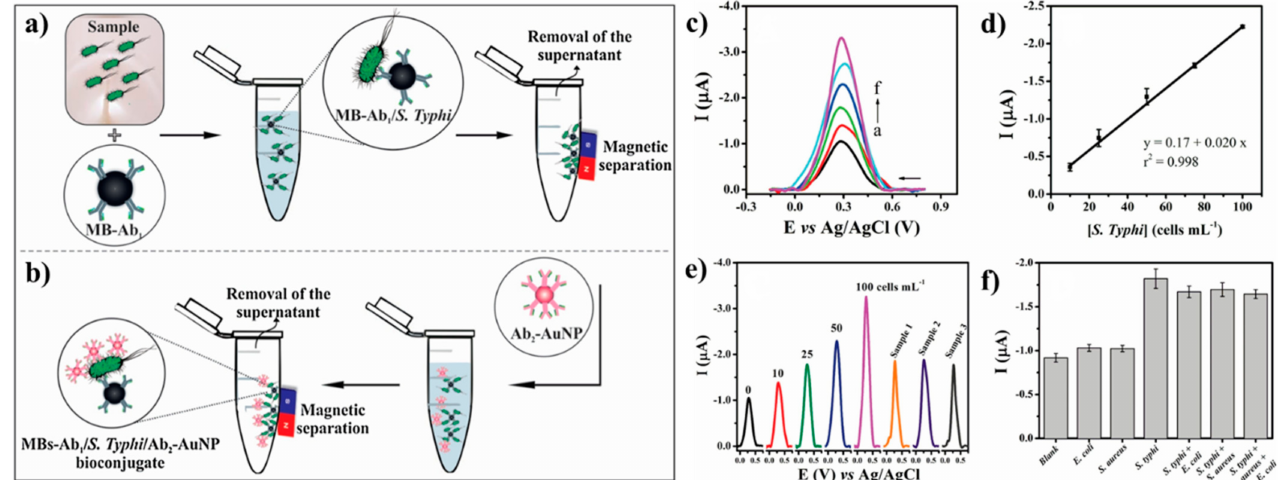
Figure 3. ( a ) Schematic illustration showing the steps involved in the offline Salmonella typhimurium capture with MB-AB1 followed by washing. ( b ) The formation of MB-Ab1/S. typhi/Ab2-AuNP magneto-immunoconjugate after the addition of Ab2-AuNP. ( c ) DPV curves for the S. typhi detection (0–100 cells/mL of bacteria) in PBS-T20 (pH 7.4). ( d ) The corresponding calibration curve (n = 8). ( e ) DPV curves obtained for the determination of Salmonella typhimurium (0–100 cells/mL) from milk sample using a single D µ FD. ( f ) Specificity study of the immunoassay, including negative control (concentration of 25 cells/mL for each bacteria). Reproduced with permission from reference [33]. Copyright © 2020 Elsevier